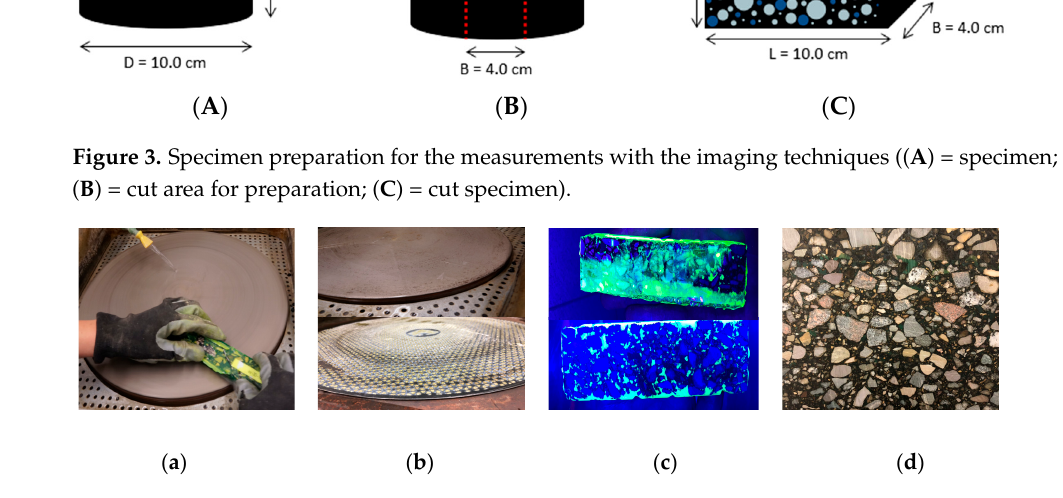
Figure 4. The grinding process of asphalt petrology: ( a ) water-cooled grinder; ( b ) different grinding wheels; ( c ) specimen before and after grinding process; ( d ) surface of specimen after grinding process (epoxy resin is only left in the voids) [18].